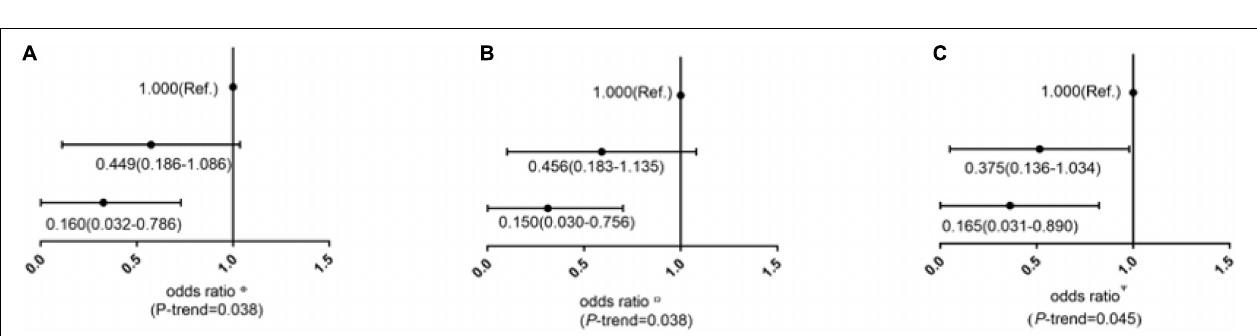
FIGURE 4 | ORs (95% CI) of psychological problems according to the frequency of nut intake in cross-sectional study. (A) Was the factor without adjustment; (B) Multivariate ORs were adjusted for age, income, occupation, residence, and marriage; (C) Multivariate ORs were adjusted for age, income, occupation, residence, marriage methamphetamine dose, methamphetamine use, admission time, and frequency of drug